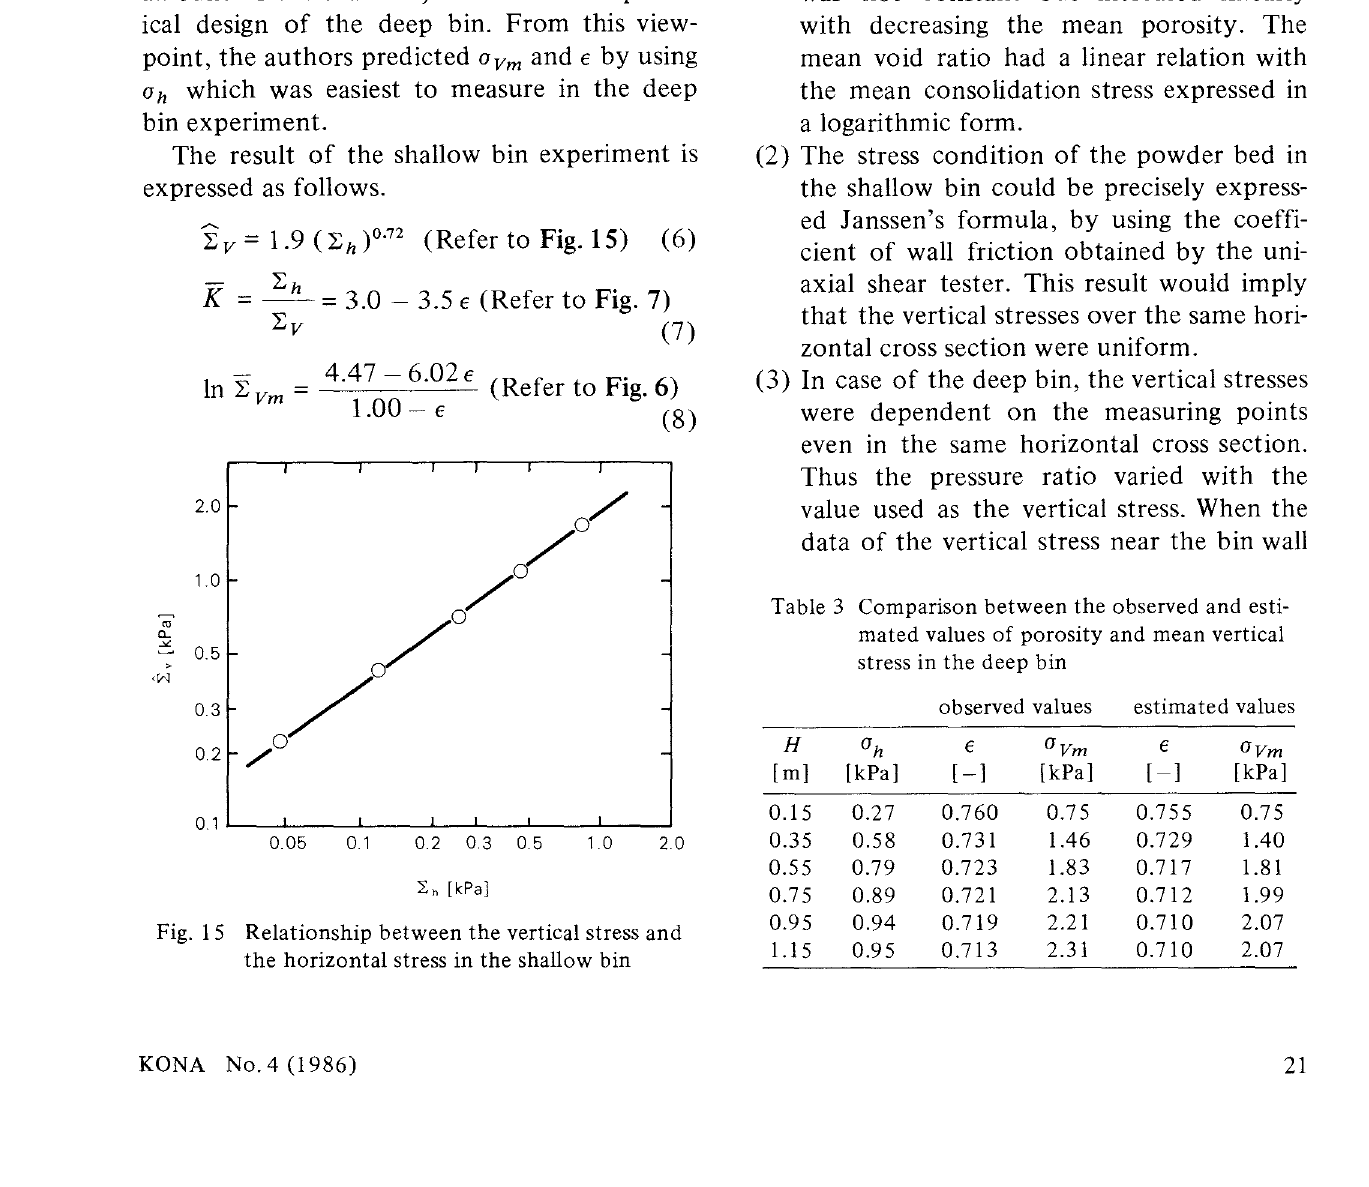
Fig. 1 5 Relationship between the vertical stress and the horizontal stress in the shallow bin